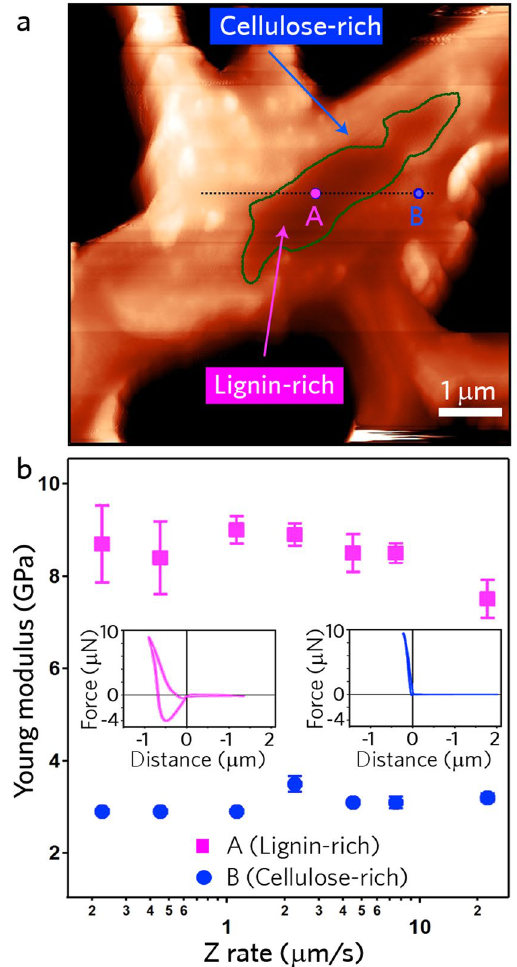
Figure 8. Material differentiation of UR solely through nanomechanical properties. ( a ) Topographic image acquired by AFM with perimeter of lignin-rich region of the cell corner lamella marked with interrogations across the material domains, specifically points A and B. ( b ) The mean Young modulus of 25 measurements at different positions, with error bars representing the overall distribution (standard deviation). Lignin-rich domains were measured to be E = ~8 GPa and for cellulose-rich E = ~3 GPa. The insets are a representative force-distance measurement for the two material